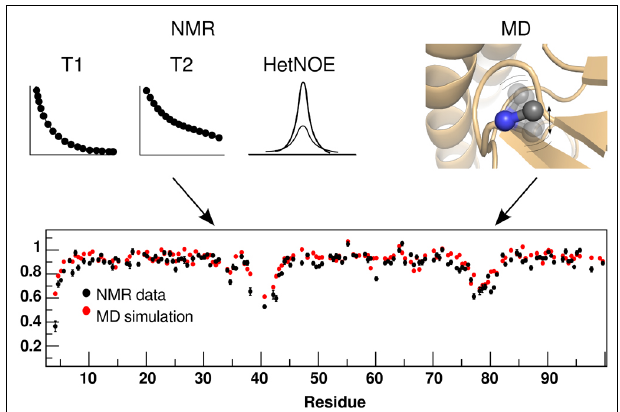
FIGURE 4 | Correspondence of dynamic parameters measured by NMR and back-calculated from an MD trajectory. The square of the backbone order parameter (S 2 shown in the bottom panel), which provides information about the amplitude of the motion of NH bonds or CH bonds, can be calculated from measured experimental parameters T1, T2, and HetNOE (black dots in the bottom panel), and from the MD trajectories (red dots in the bottom panel). The resulting values, for both approaches, can be compared